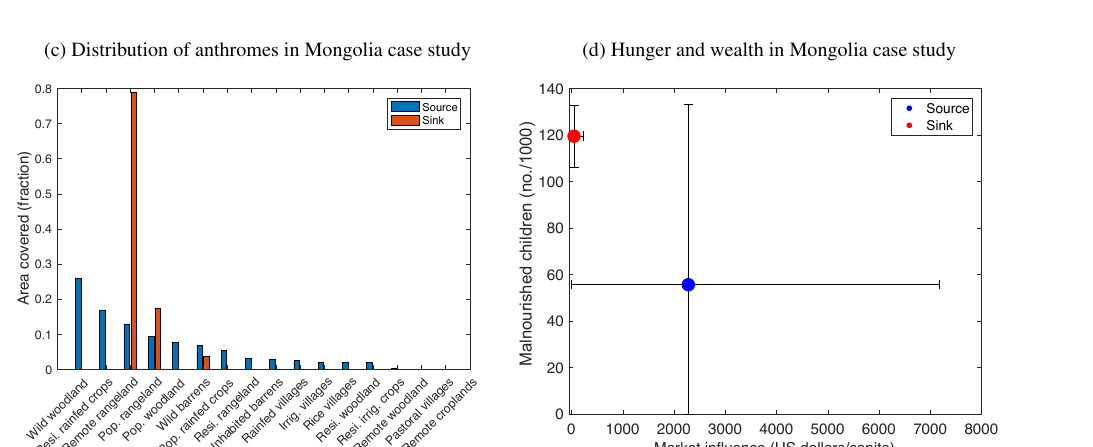
Figure 2. Mongolia case study including (a) precipitationshed analysis, (b) key source countries, (c) comparison of land uses between the country and its precipitationshed, and (d) comparison of economic and food security aspects of country and source regions.